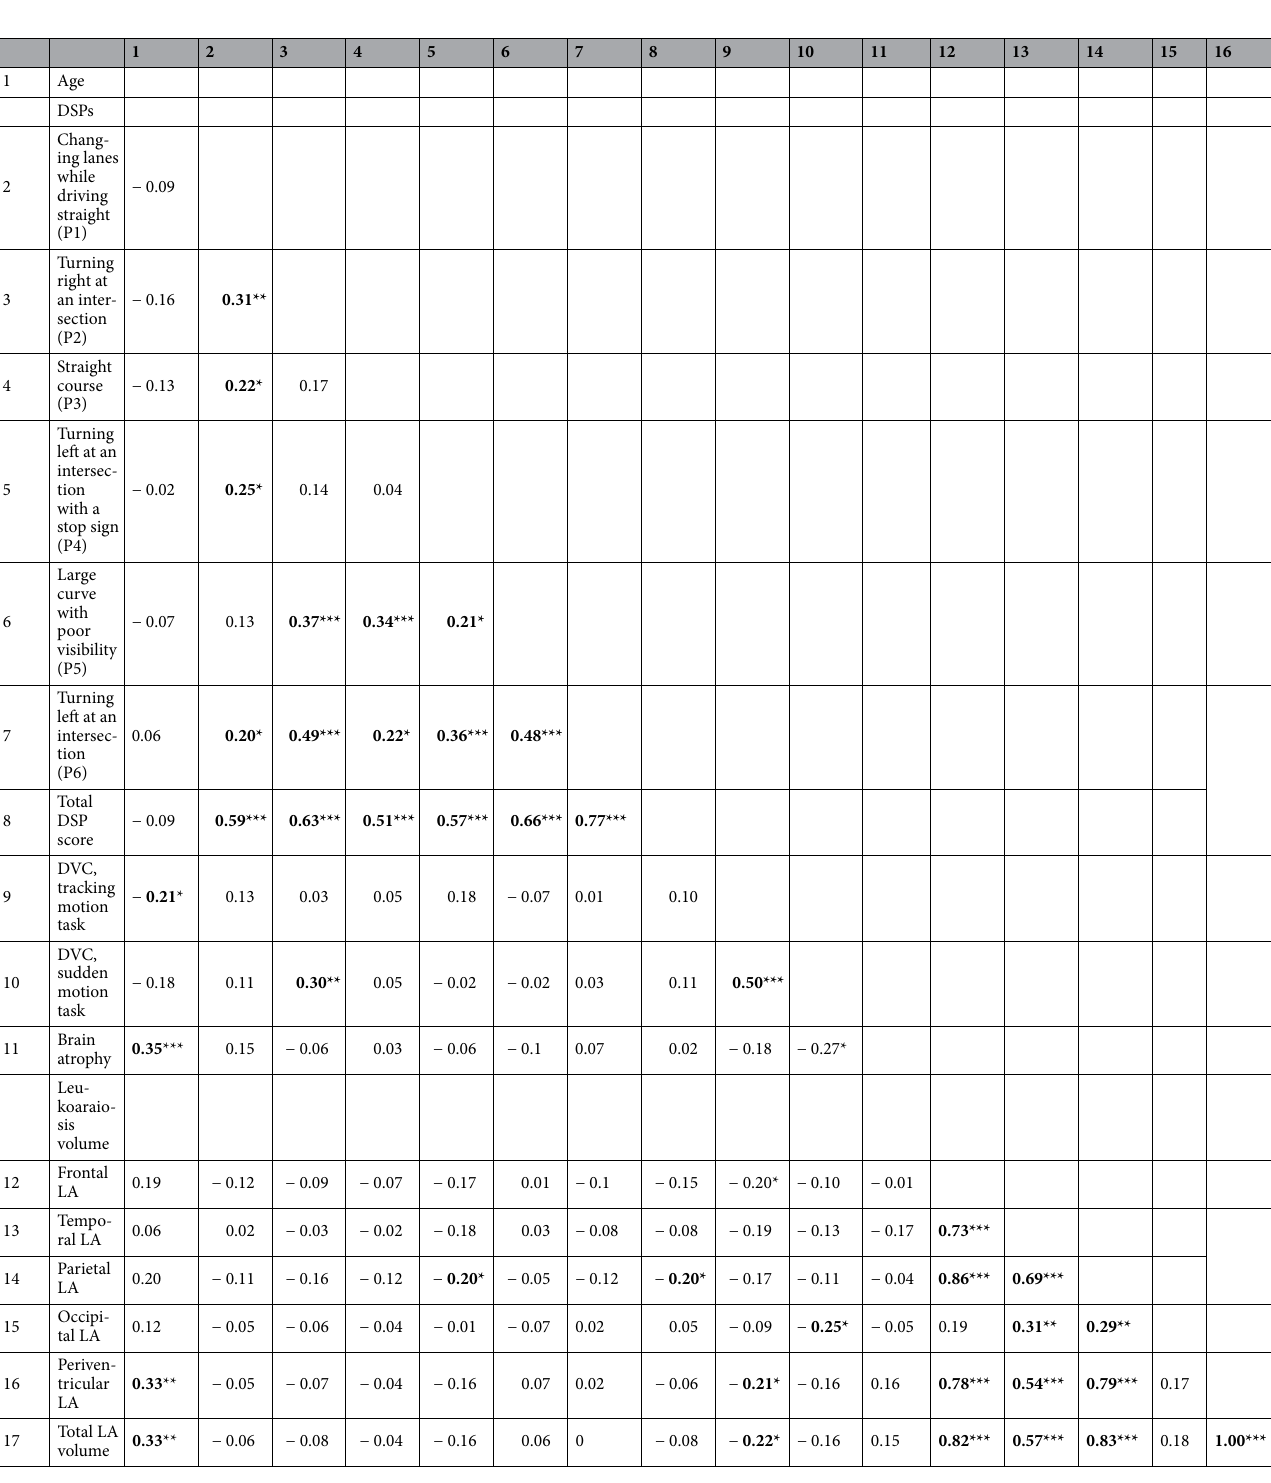
Table 3. Univariate correlation analysis of all variables. Significant values are in bold. DSP driving safety performance, DVC dynamic visual cognition, LA leukoaraiosis; * p < 0.05, ** p < 0.01, *** p <